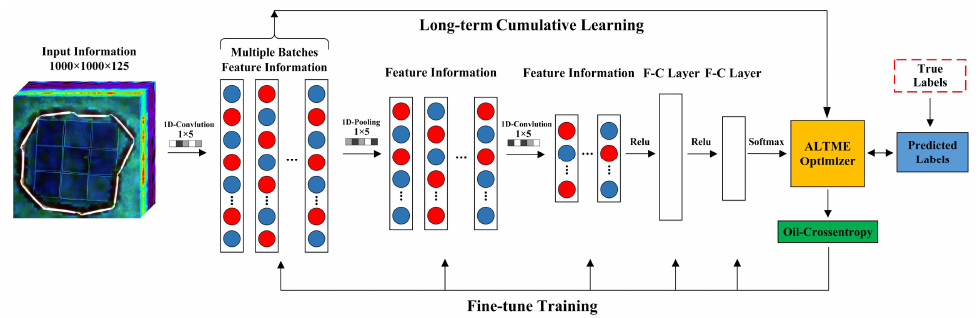
Figure 9. Structure of the marine oil spill detection 1D-CNN model.